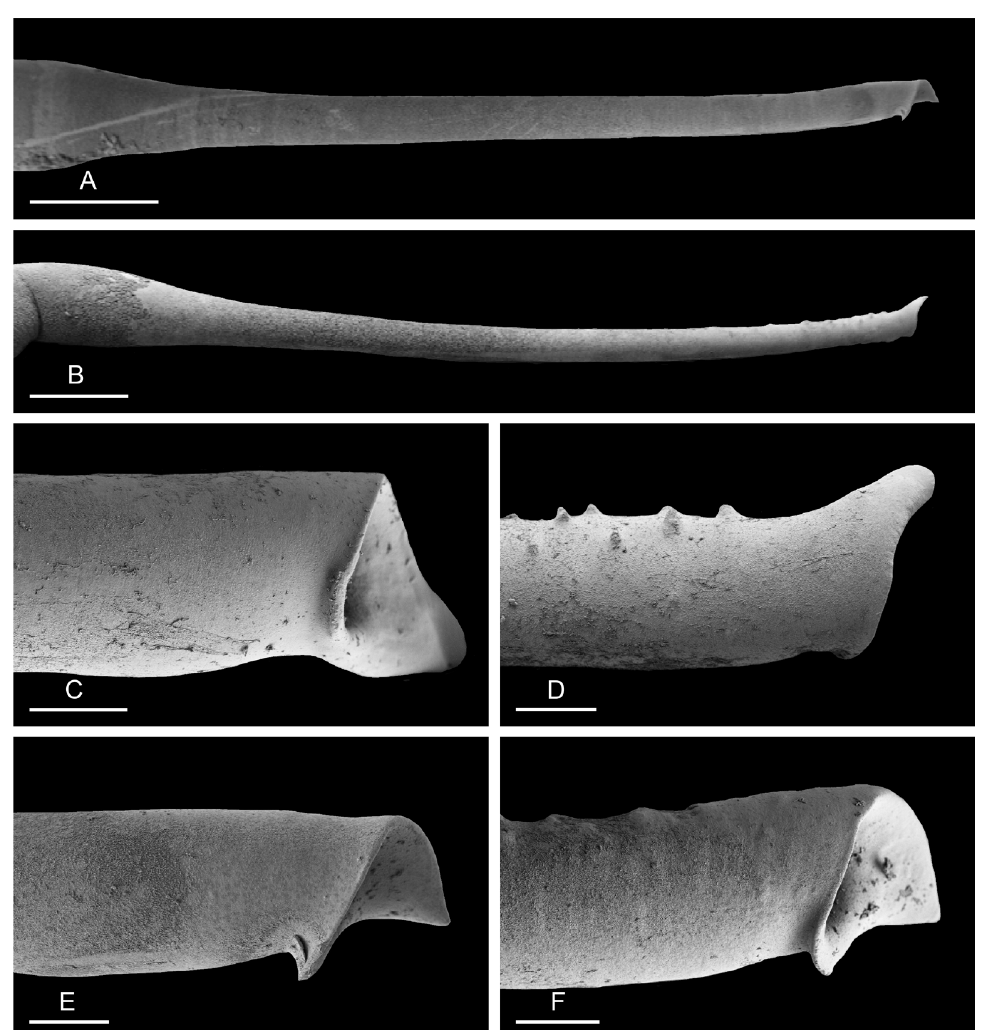
Fig. 38. Paromoionchis boholensis gen. et sp. nov., unit #2, spine of accessory penial gland. A . Indonesia, Bali [3117] (UMIZ 00140). B . Indonesia, Kei [2911] (UMIZ 00149). C . Tip of spine, Indonesia, Ambon [2851] (UMIZ 00146). D . Distal tip of spine, same as B. E . Tip of spine, same as A. F . Tip of spine, Indonesia, Halmahera [5140] (UMIZ 00152). Scales: A–B = 200 μm; C–F = 30